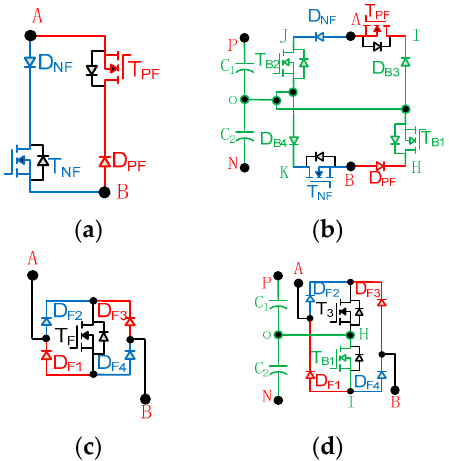
Figure 13. Direct Connection NPC cell circuits based on topology family with an extra diode. ( a ) Case #1; ( b ) NPC cell under case #1; ( c ) Case #2; ( d ) NPC cell under case #2 (new).